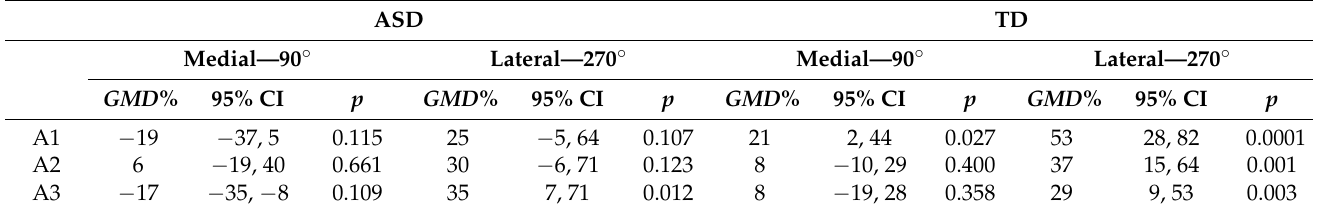
Table 5. Within group effects of between test comparisons (medial—90 ◦ ) and (lateral—270 ◦ ) contrasts. ASD